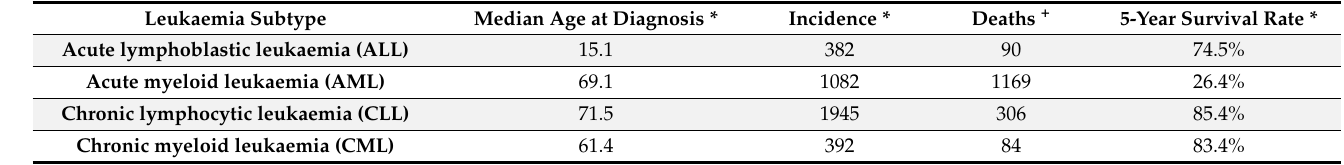
Table 1. Leukaemia statistics in